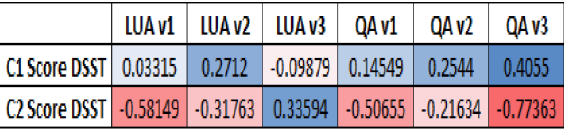
Fig. 16 Scanning index for class D fixation data for 2 age groups